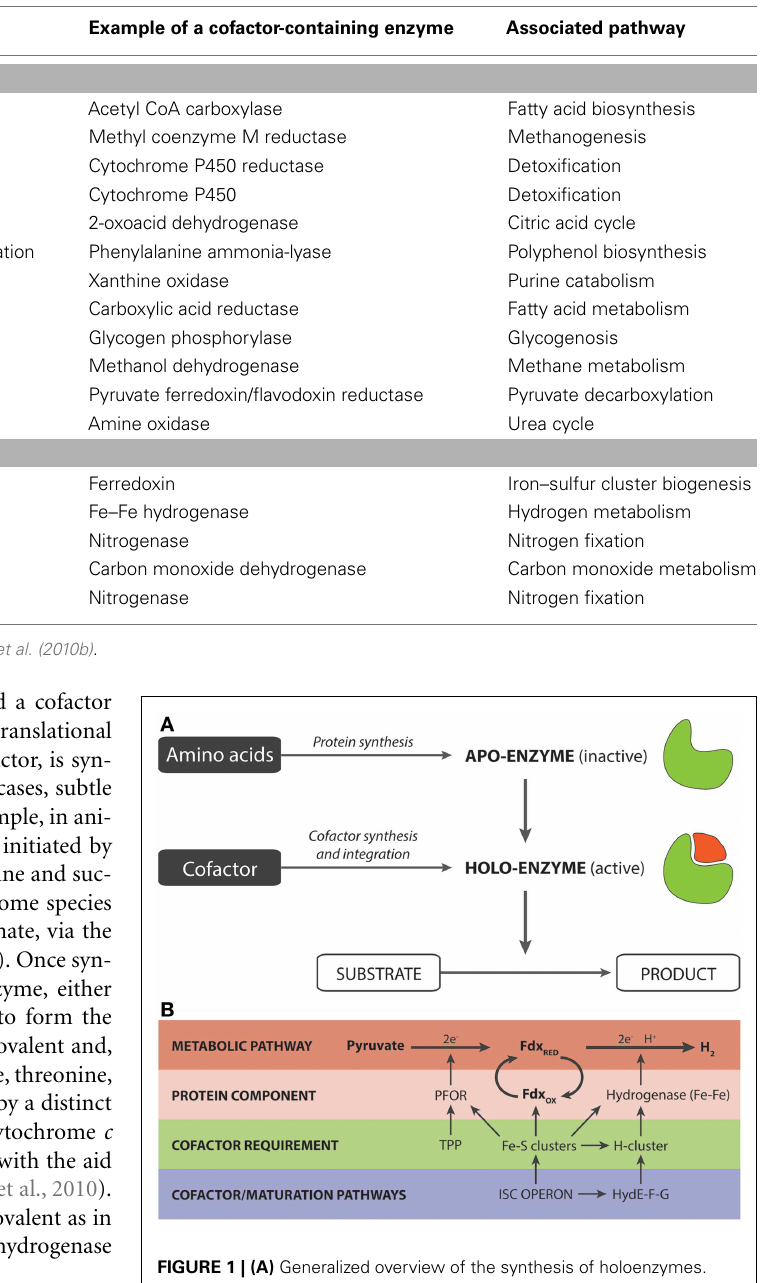
FIGURE 1 | (A) Generalized overview of the synthesis of holoenzymes. (B) Significance of cofactor engineering for enhancing the output